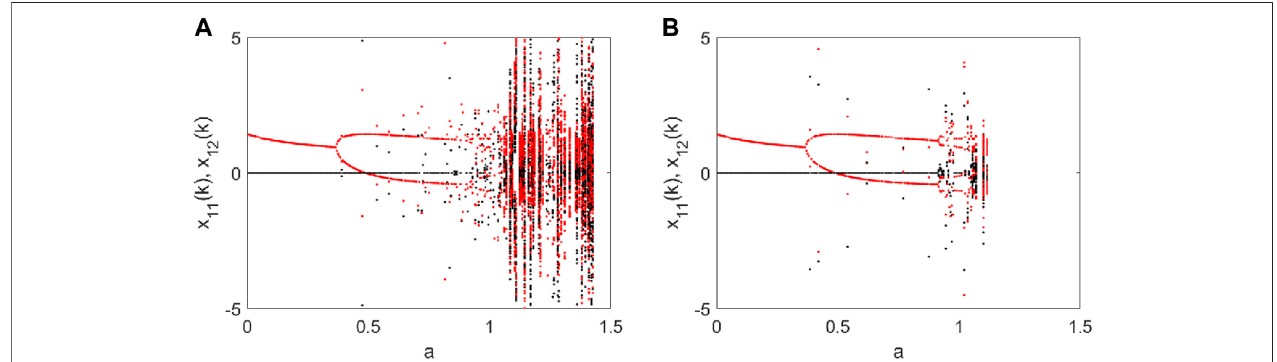
FIGURE 12 | Bifurcationdiagram ofthe multidimensional Henon mapin Eq.18 withrespect to a : (A) N = 2 and X(0)and Y(0)withthe same eigenvector set; (B) N = 2 and X(0) and Y(0) with different eigenvectors. Other parameters: b = 0.3.